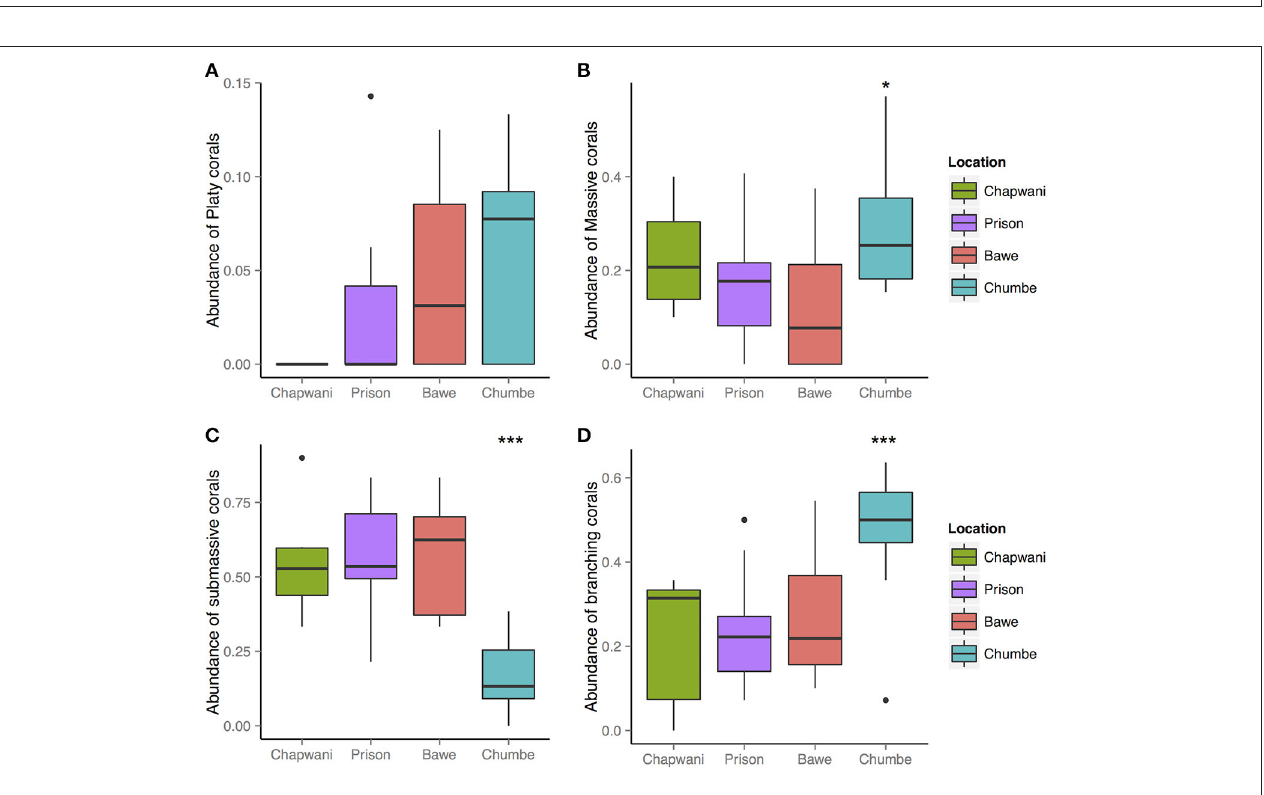
FIGURE 3 | Overview of the hard coral morphological categories: (A) platy; (B) massive; (C) submassive; and (D) branching corals. An analysis of variance showed significant differences between the massive, submassive, and branching coral morphologies F 3 - 38 = 4.257, p = 0.0109*; F 3 - 38 = 16.04 6.79e-07***; and F 3 - 38 = 7.197, p = 0.00061***, respectively. However, the distribution of platy corals do not show strong spatial differences F 3 - 38 = 2.444, p = 0.078.